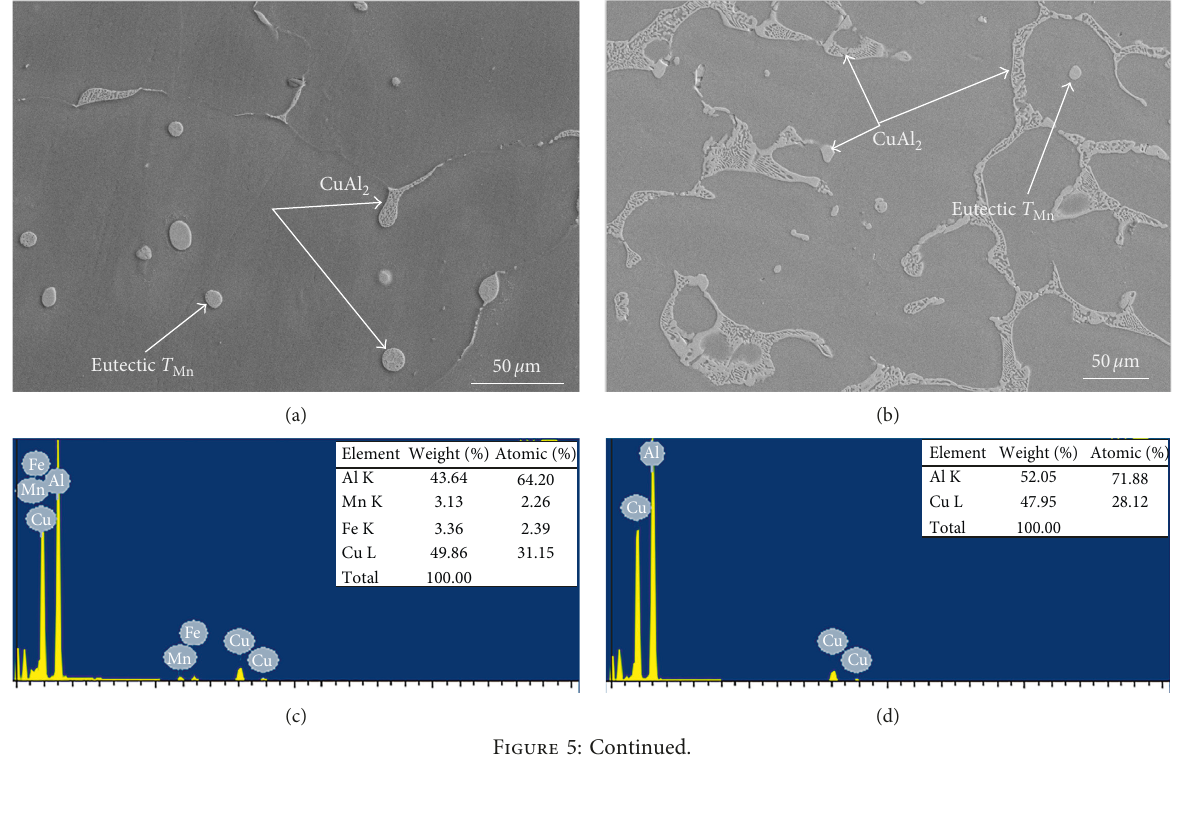
1 alloy; (b) A 2 alloy; (c) A 3